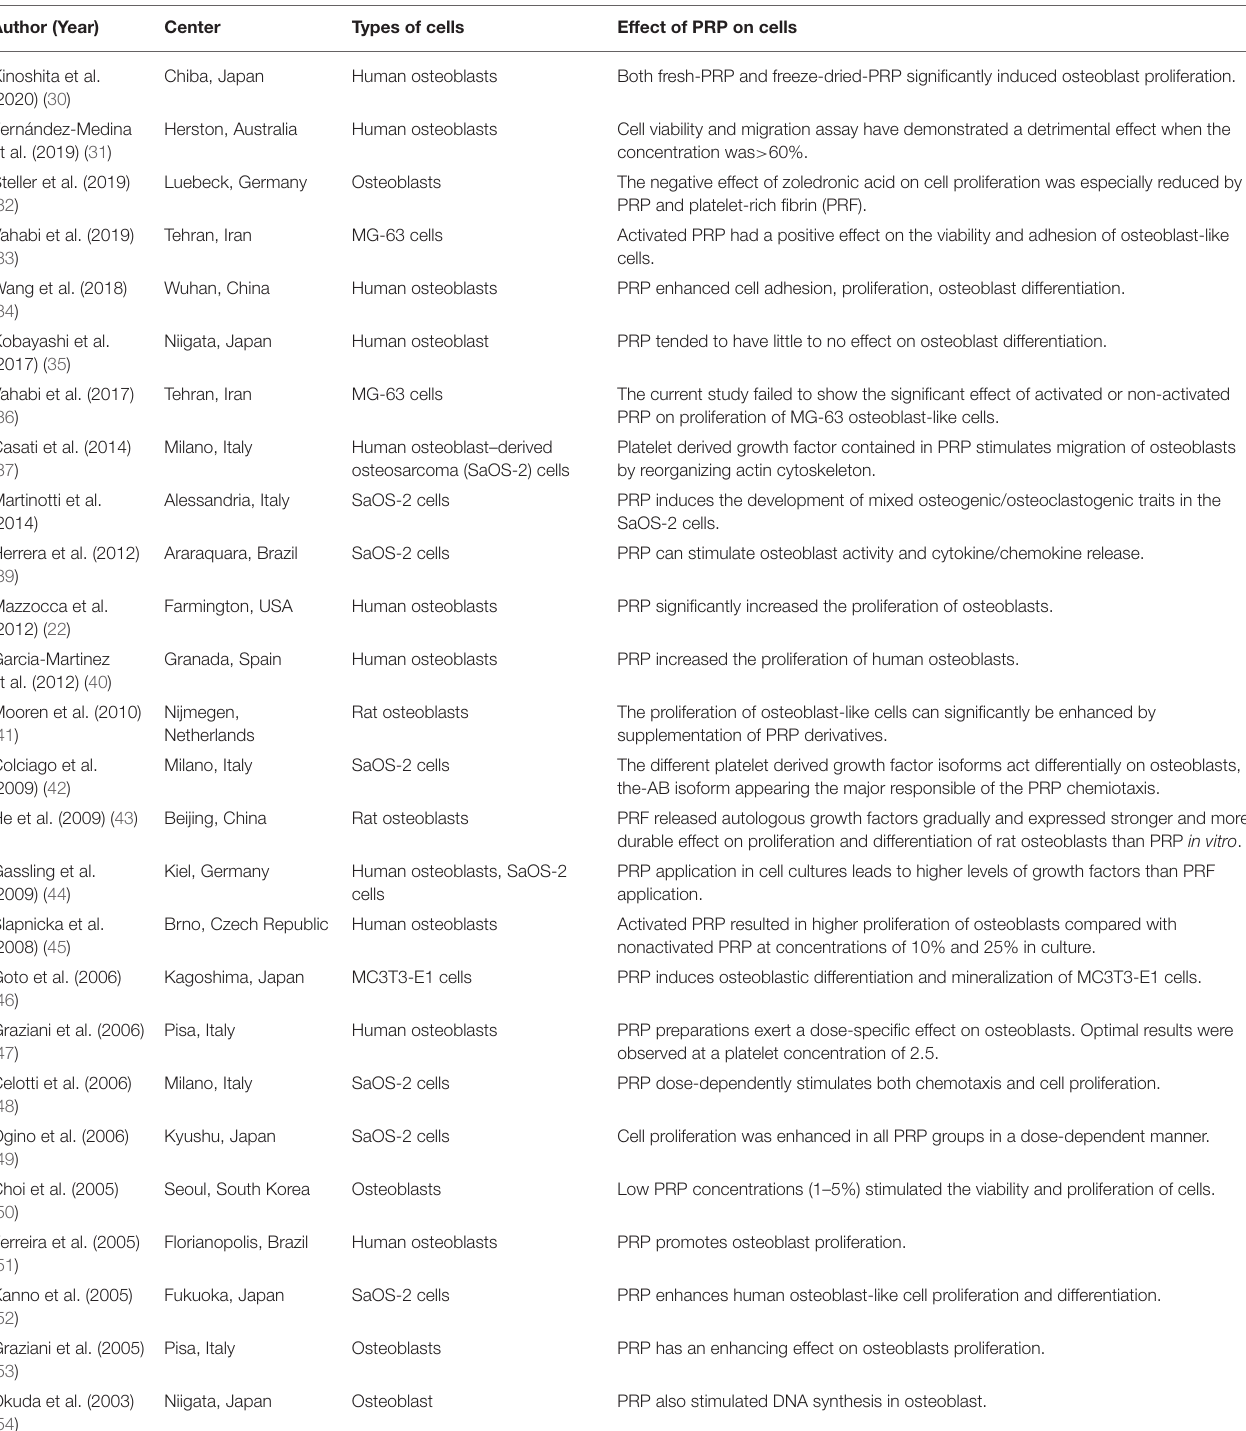
TABLE 1 | The main details of in vitro preclinical